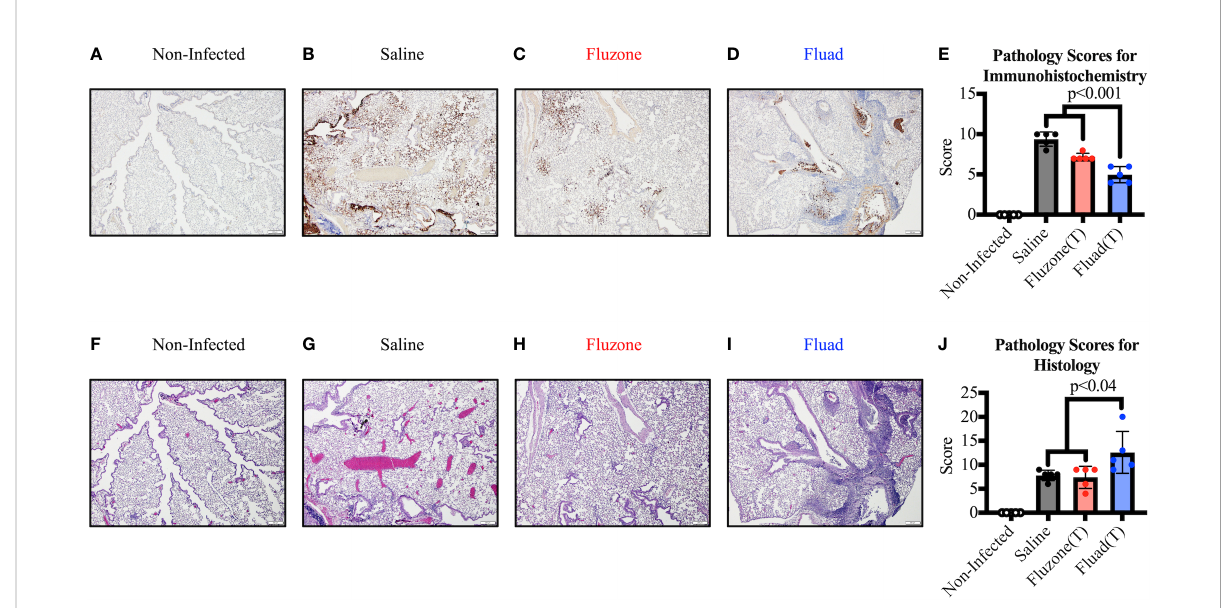
FIGURE 5 Immunohistochemistry and histopathology of mouse lungs following vaccination with commercial in fl uenza vaccines and subsequent challenge with Yamagata lineage in fl uenza B virus. (A – D) Representative images show immunohistochemistry (IHC) against the in fl uenza B nucleoprotein protein for different vaccination groups. (A) Uninfected lungs from sham inoculated mice exhibit no viral antigen staining. (B) Positive-control lung from the saline vaccinated group displays viral antigen (brown) along large airway epithelium and affecting greater than 50% of the alveolar interstitium. (C) Lung from the Fluzone (T) vaccinated group shows considerably less viral antigen (brown) in the alveolar interstitium compared to the positive control. (D) Lung from the Fluad (T) vaccinated group displays viral antigen (brown) in less than 10% of the interstitium; the majority of the antigen present is associated with airway epithelium and within airway lumina. All images at 4x, (scale bar is 200 m m). (E) Immunohistochemical scoring based on relative amount of in fl uenza antigen in sections. (F – I) Serial sections of lung were used to detect in fl ammation by routine H&E. (F) Negative-control lung from non-infected group is histologically normal. (G) Positive-control lung from the saline vaccinated group displays airway epithelial changes but minimal changes in the alveolar interstitium. (H) Lung from the Fluzone (T) vaccinated group exhibit similar airway changes as the positive-control lung. (I) Lung from the Fluad (T) vaccinated group shows similar pulmonary changes as well as robust perivascular in fl ammation in some areas. All images at 4x, (scale bar is 200 m m). (J) Histology scoring based on in fl ammation in